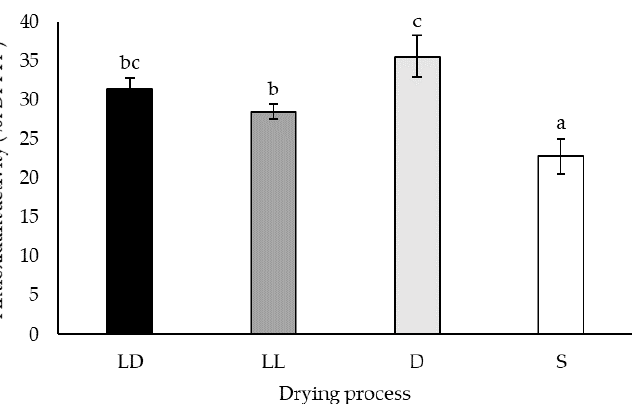
Figure 3. Antioxidant capacity of the ethanolic extracts of Agave lechuguilla bagasse freeze-dried in the dark (LD), exposed to light (LL), oven-dehydrated (D), and sun-dried (S) expressed as a percentage of the scavenging of the DPPH radicals (% I DPPH). The given letters “a”, “b”, “c”, and “bc” indicate significant differences as per Tukey HSD analysis (n = 4, p <